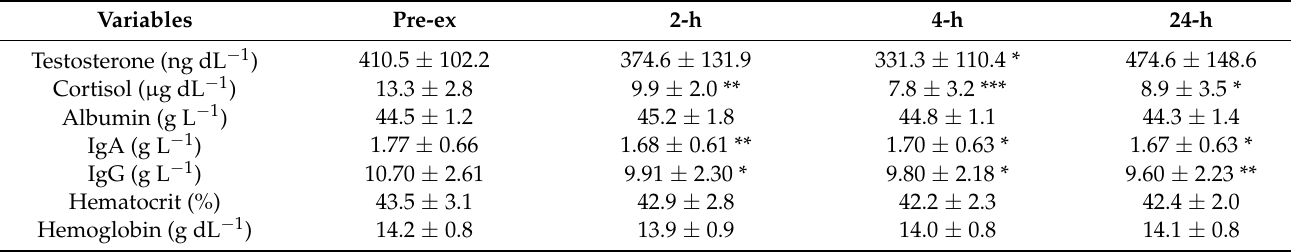
Table 2. Mean ± SD of serum testosterone, cortisol, Albumin, immunoglobulin A (IgA), immunoglobulin G